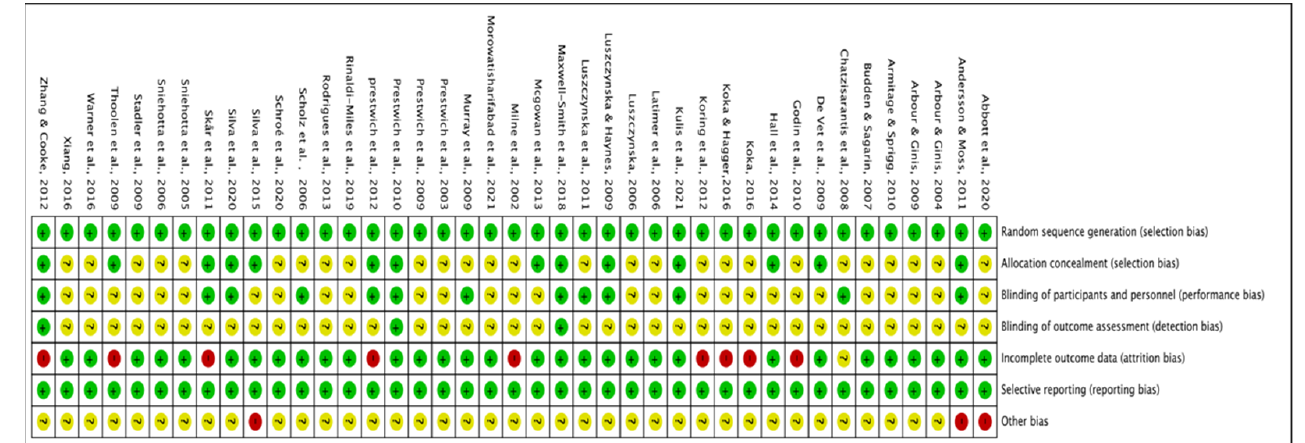
Figure 3. Risk of bias summary for included studies [30–70].